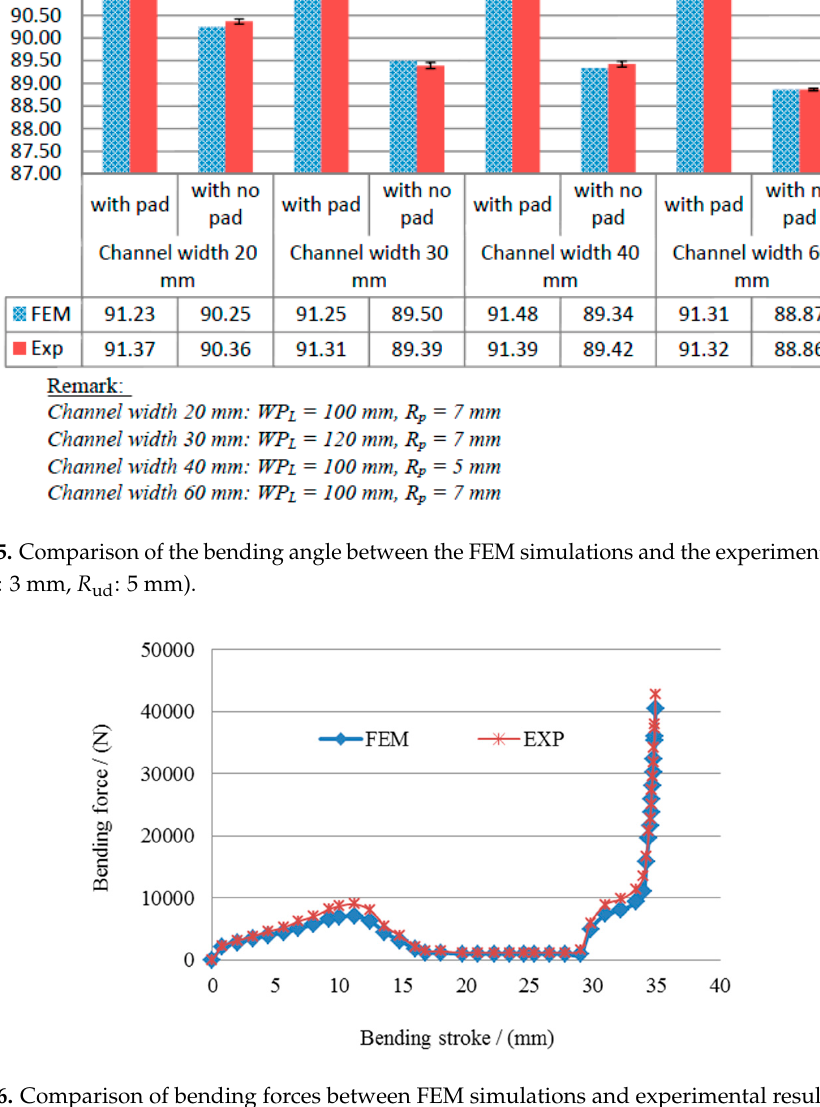
Table 3. The amounts of spring-back in cases where pressure pads and no pressure pads were used, analyzed using FEM simulations.